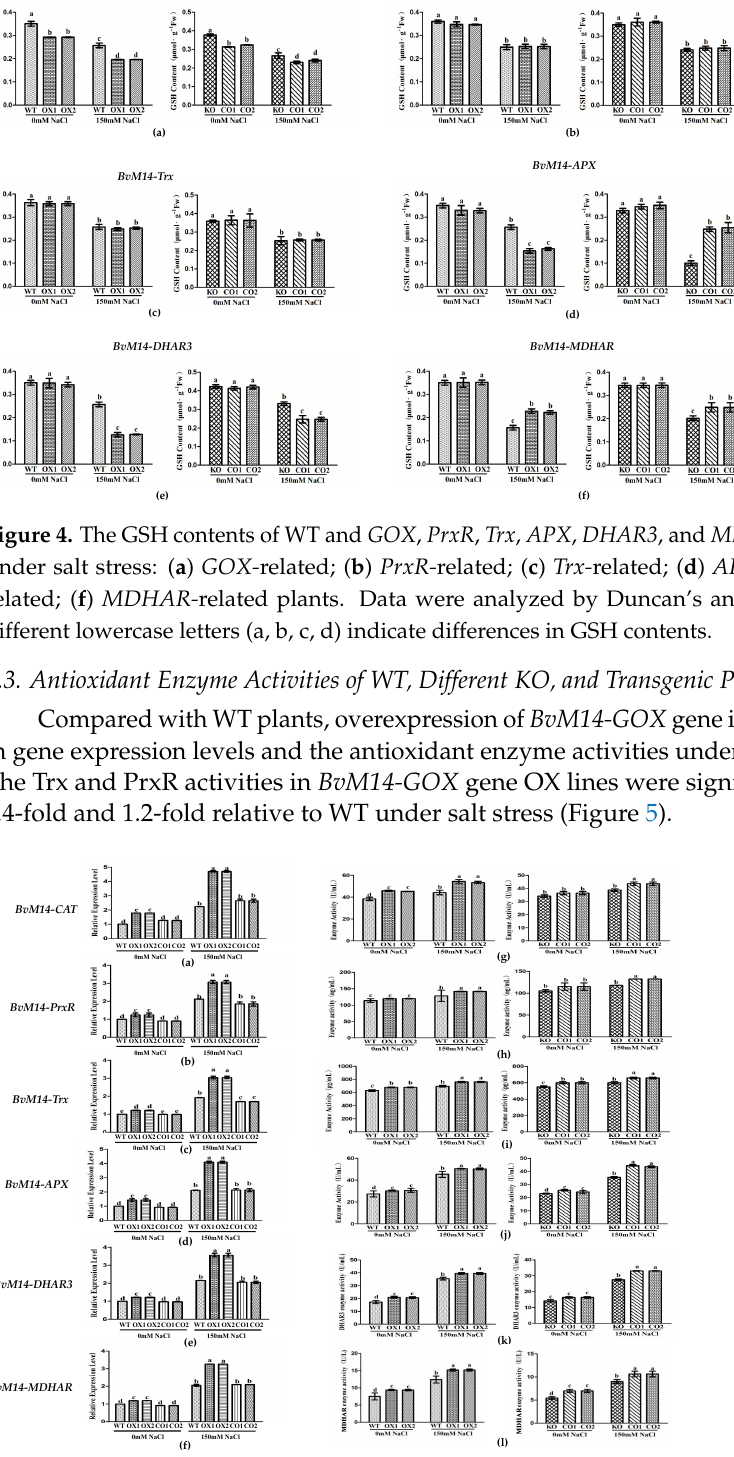
Figure 5. Analyses of relative gene expression and enzyme activities in GOX -related plants un- der salt stress: ( a – f ) Expression of antioxidative genes ( BvM14-CAT , BvM14-PrxR , BvM14-Trx , BvM14-APX , BvM14-DHAR3 , and BvM14-MDHAR ) in WT and GOX -related plants under salt stress; ( g – l ) antioxidant enzyme activities ( Bv M14-CAT, Bv M14-PrxR, Bv M14-Trx, Bv M14-APX, Bv M14- DHAR3, and Bv M14-MDHAR) in WT and GOX -related plants under salt stress. Data were